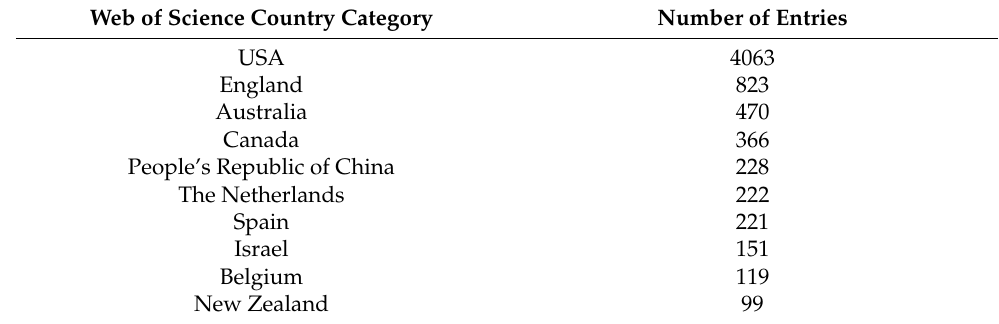
Table 1. Top 10 publishing countries.